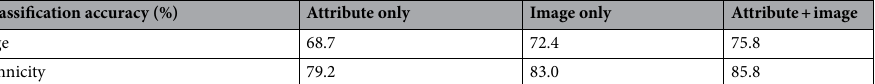
Classification accuracy (%) Attribute